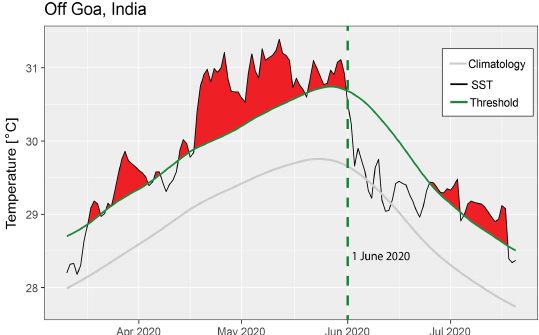
Figure 15. Event line during March–July 2020 at a location off the west coast of India (off Goa). The green dashed line represents the date when the Nisagra cyclone passed over off Goa,